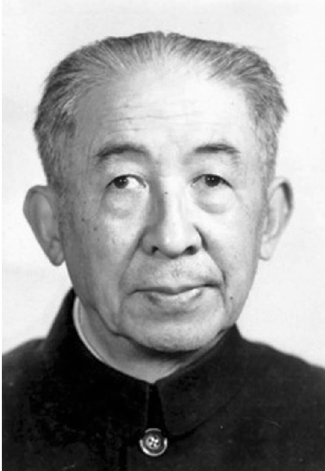
Figure 1. Dejun Yu (Te-tsun Yu, Feb. 1, 1908 – July 14, 1986).